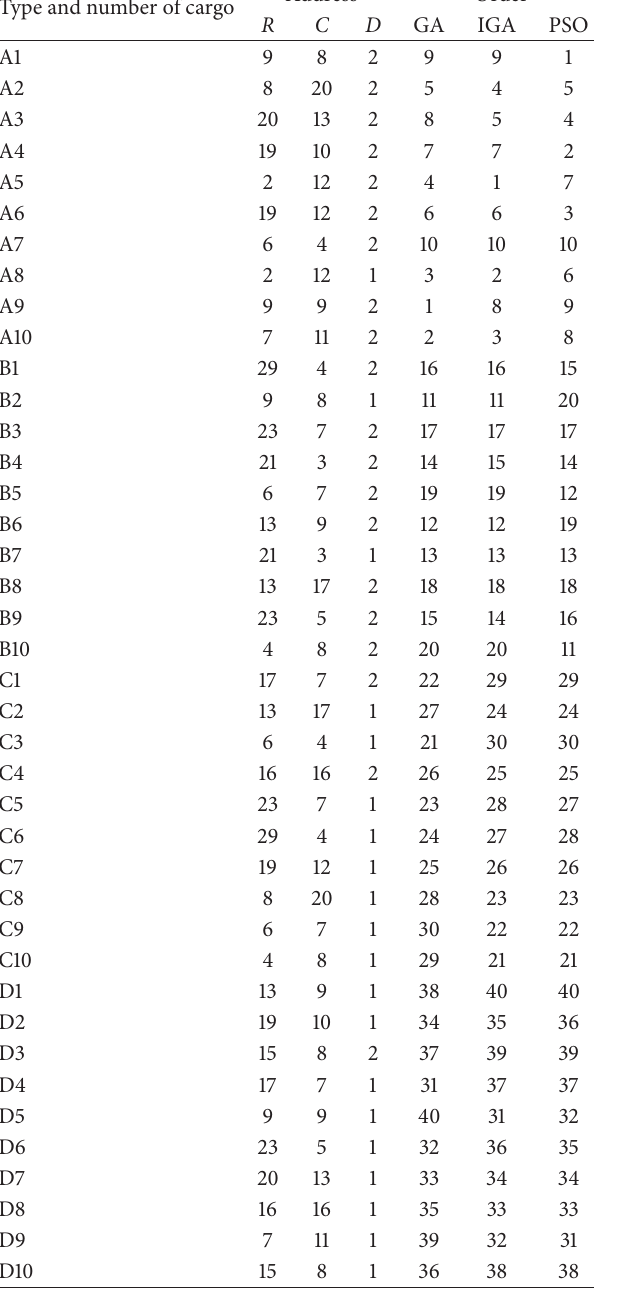
Table 5: The addresses of the stored cargo for simulation in Case 5. Type and number of cargo